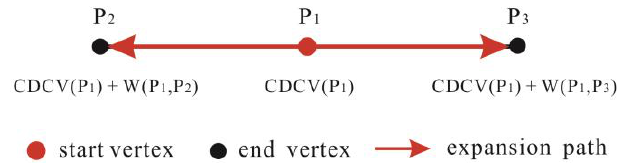
Figure 4. A basic expansion is a motion from a source (start) vertex to a target (end) vertex, the path between which is the expansion path. Current distance to central vertex (CDCV) ( p ) represents p ’s current distance to central vertex, and W ( p , q ) denotes the weight (length) of expansion path between vertices p and q . The CDCV of end vertex is updated to the sum of CDCV of start vertex and the weight of expansion path between them. Table 1. Pseudocode of local shortest-path distance (LSPD) Algorithm.